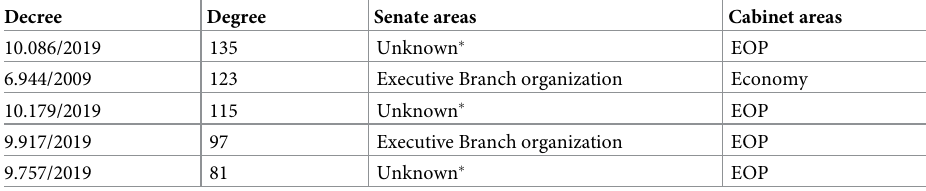
Table 10. Top 5 decrees according to degree centrality.